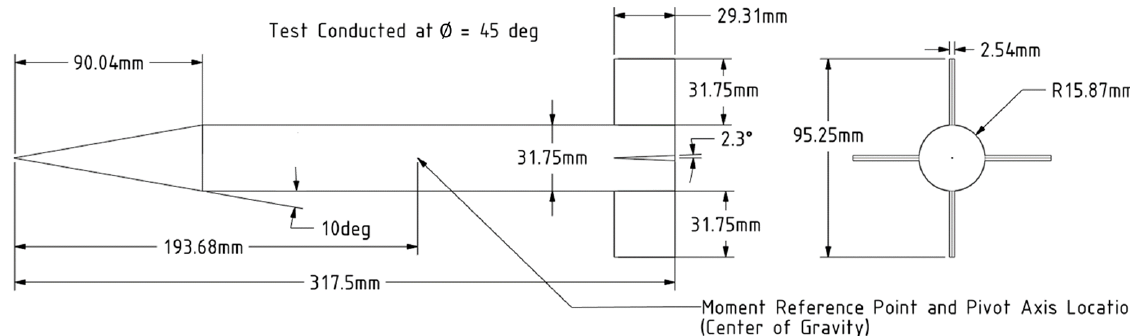
Figure 3. Army ‐ Navy Finner (ANF) missile configuration: l / d = 10. Figure 3. Army-Navy Finner (ANF) missile configuration: l / d =